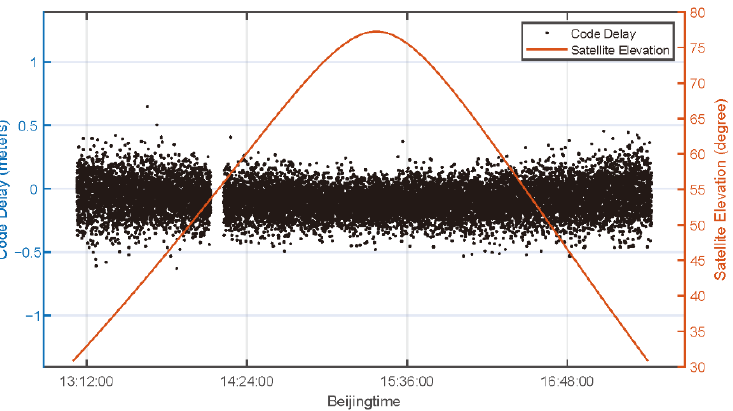
Figure 6. Time distribution of B2a PRN 37 satellite code signal path differences and satellite eleva-